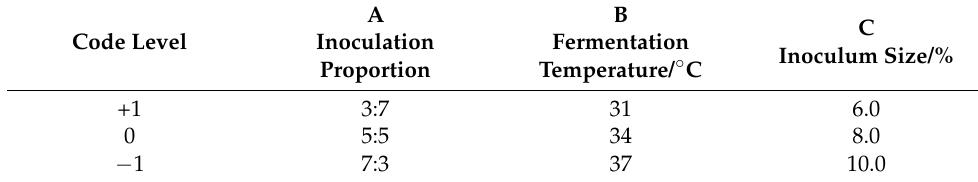
Table 3. Independent variable